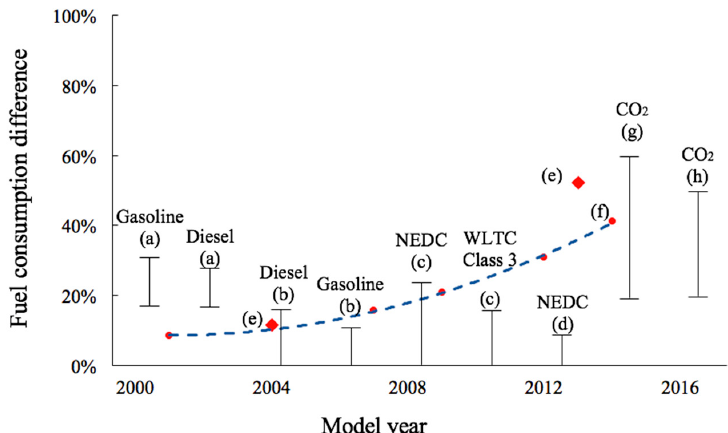
Figure 1. Relative differences of the values reported by manufacturers with respect to the real fuel consumption or real CO 2 emissions as function of the vehicles’ model year. Sources: (a) [1], (b) [2], (c) [3], (d) [4], (e) [5], (f) [6], (g) [7], and (h) [8]. Dotted lines shows the tendency obtained from the data of reference (f) which are shown as red dots. References e-h include diesel and gasoline.